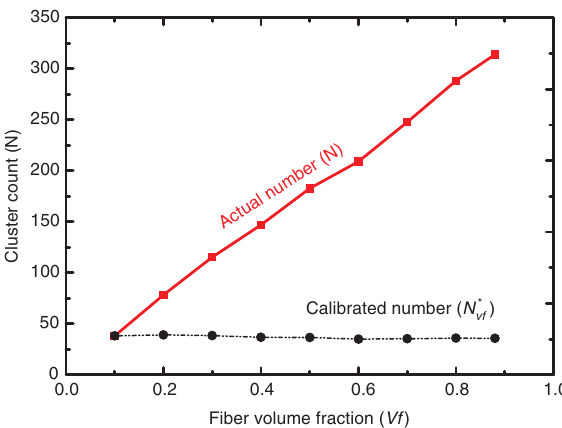
Figure 14: Volume fraction vs. final clustering score and asymptote line representing the indeterminable clustering score for densest